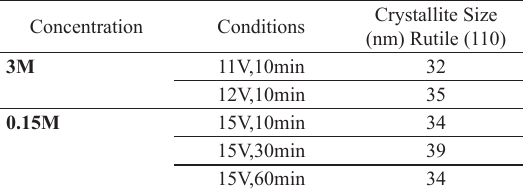
Table 1. Size of the small crystal from the rutile peaks with orientation